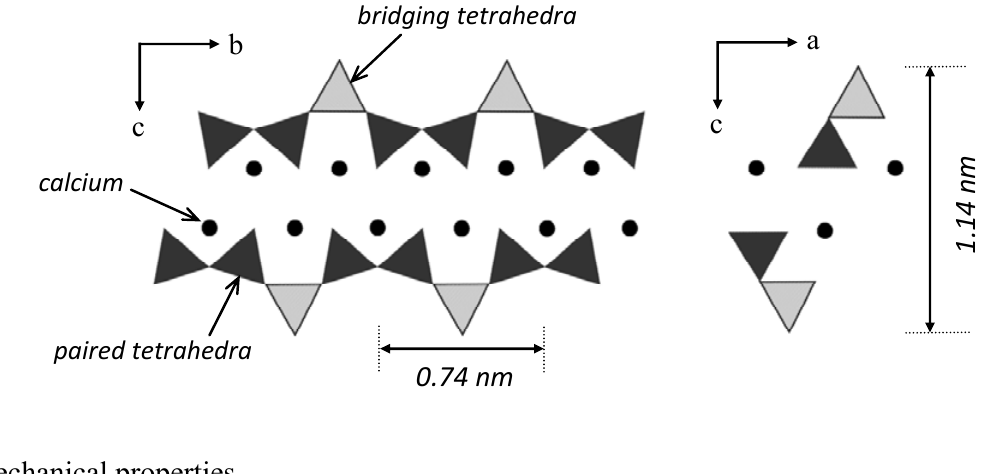
Figure 2. The schematic molecular structure of a single sheet of tobermorite. Circles: calcium atoms located at the center of Ca-O octahedra; Triangles show silicate tetrahedra ; OH - attachments are not shown. Various tobermorite systems exist that vary in the interlayer distance, i.e., 9, 11 and 14 Å